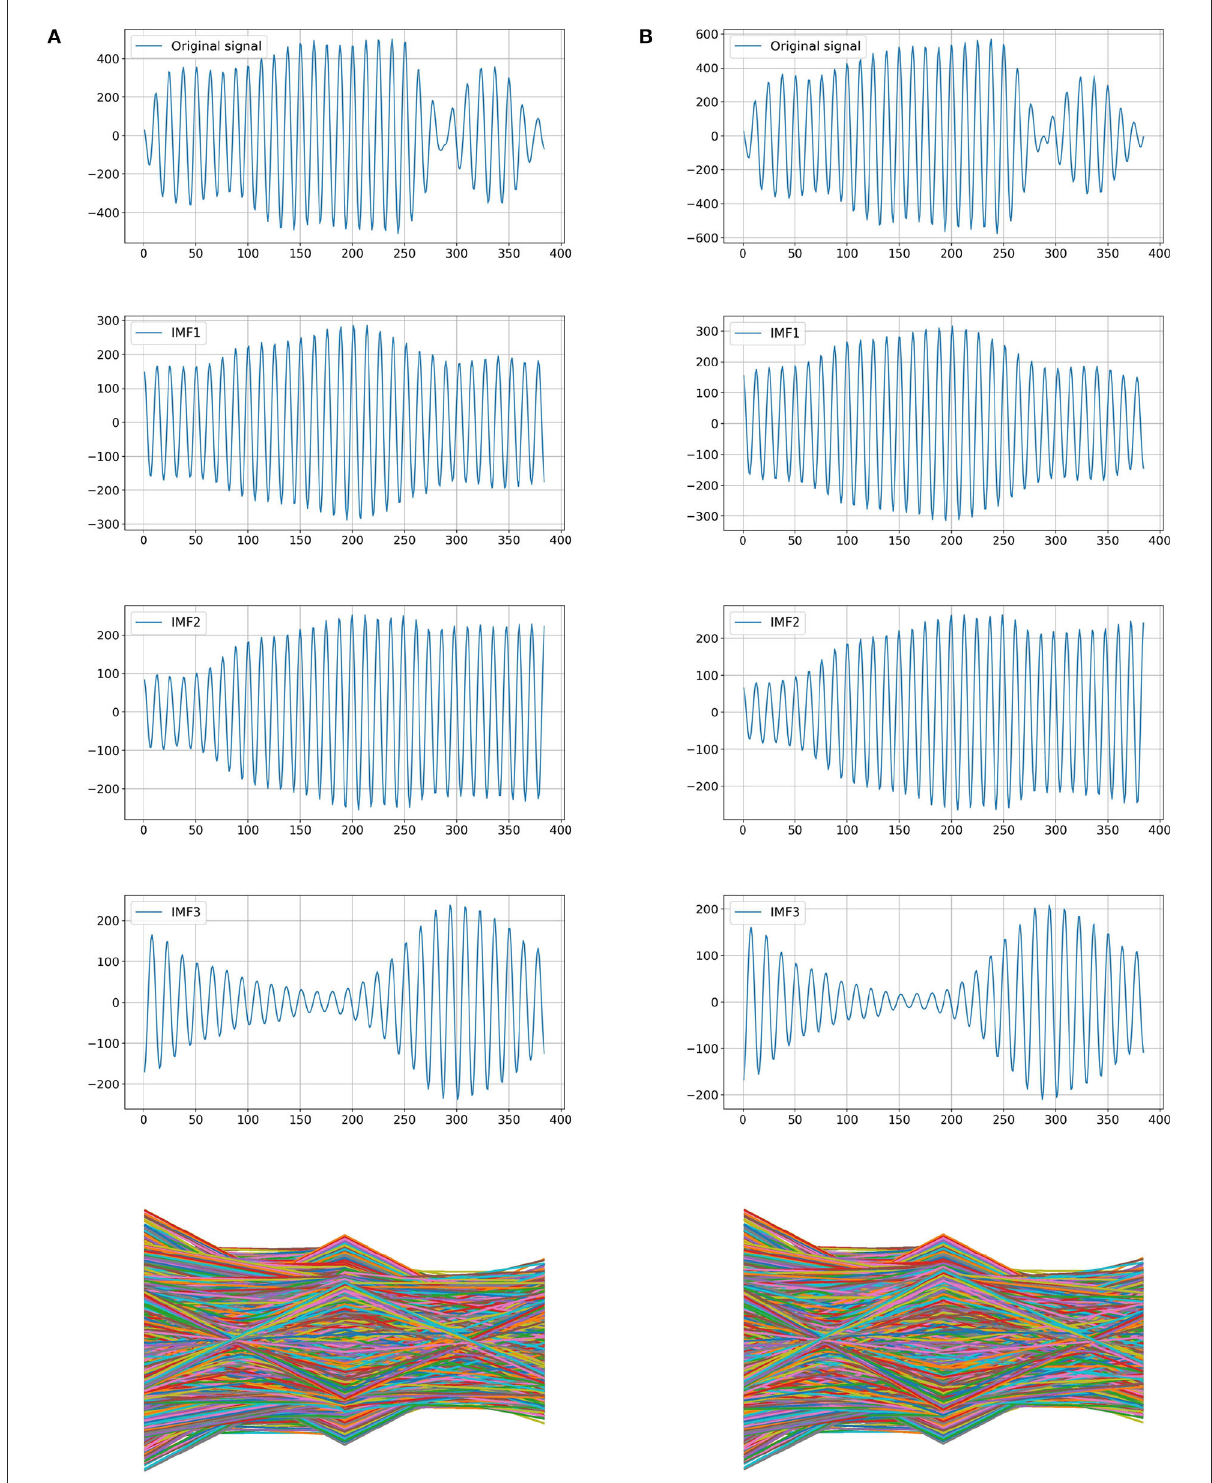
FIGURE5 Colorful images generated from the ultrasonic signals. (A) The process of generating image from the ultrasonic signal of intact cottonseed. (B) The process of generating image from the ultrasonic signal of slightly cracked